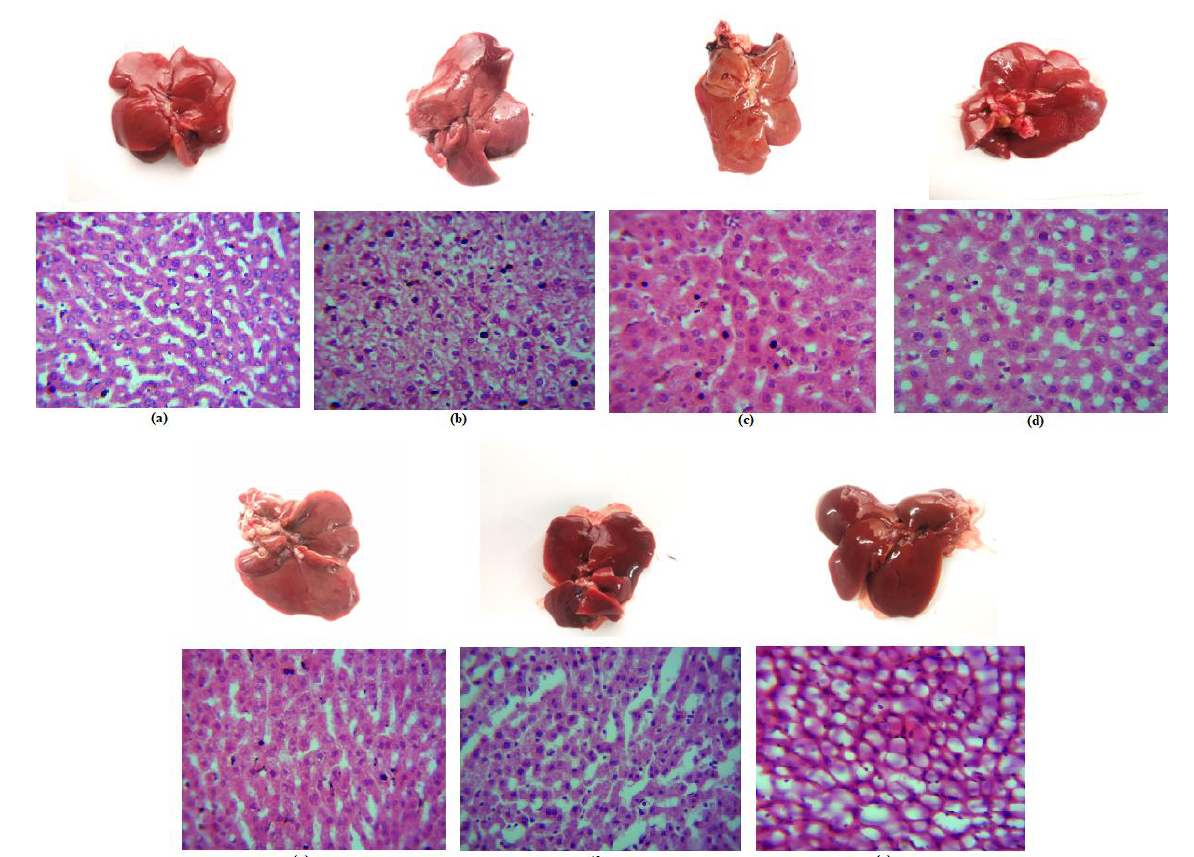
Figure 11. Liver histopathology of rats after sacrifice following the treatments for a period of 21 days ( a ) normal ( b ) diseased ( c ) BLNPs Treated (500 µg/kg BW) ( d ) silymarin treated (10 mg/kg BW) ( e ) SLNPs Treated (500 µg/kg BW) ( f ) Zn Treated (10 mg/kg BW) ( g ) ZSLNPs Treated (10 mg/kg BW + 500 µg/kg BW).